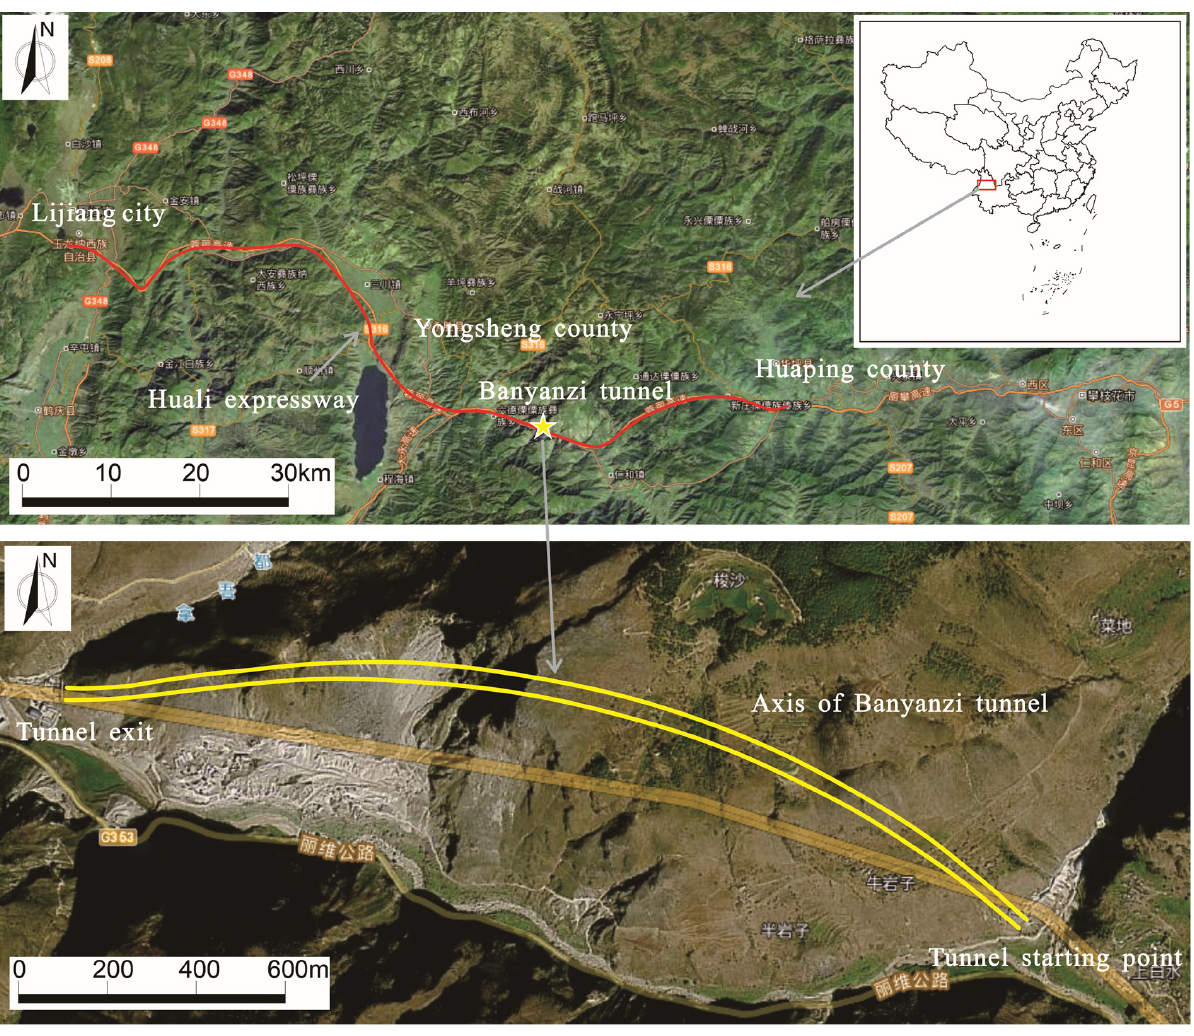
Figure 1. Geographical location of the tunnel.